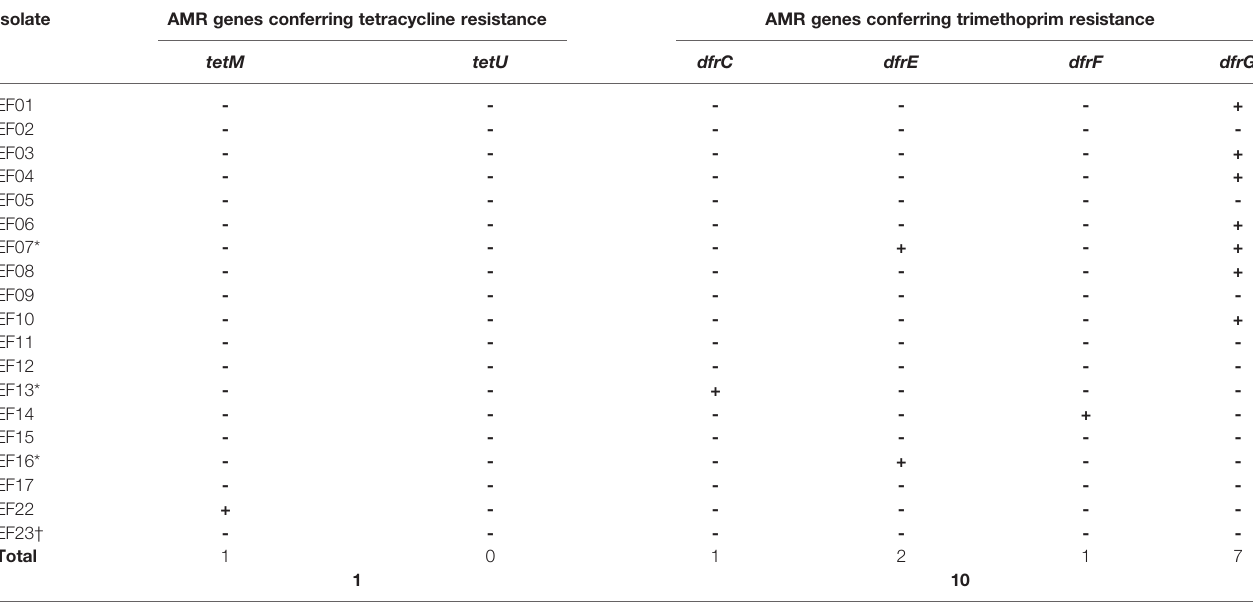
TABLE 6 | Genes detected by long-read next-generation sequencing that confer antimicrobial resistance (AMR) to tetracycline and trimethoprim.